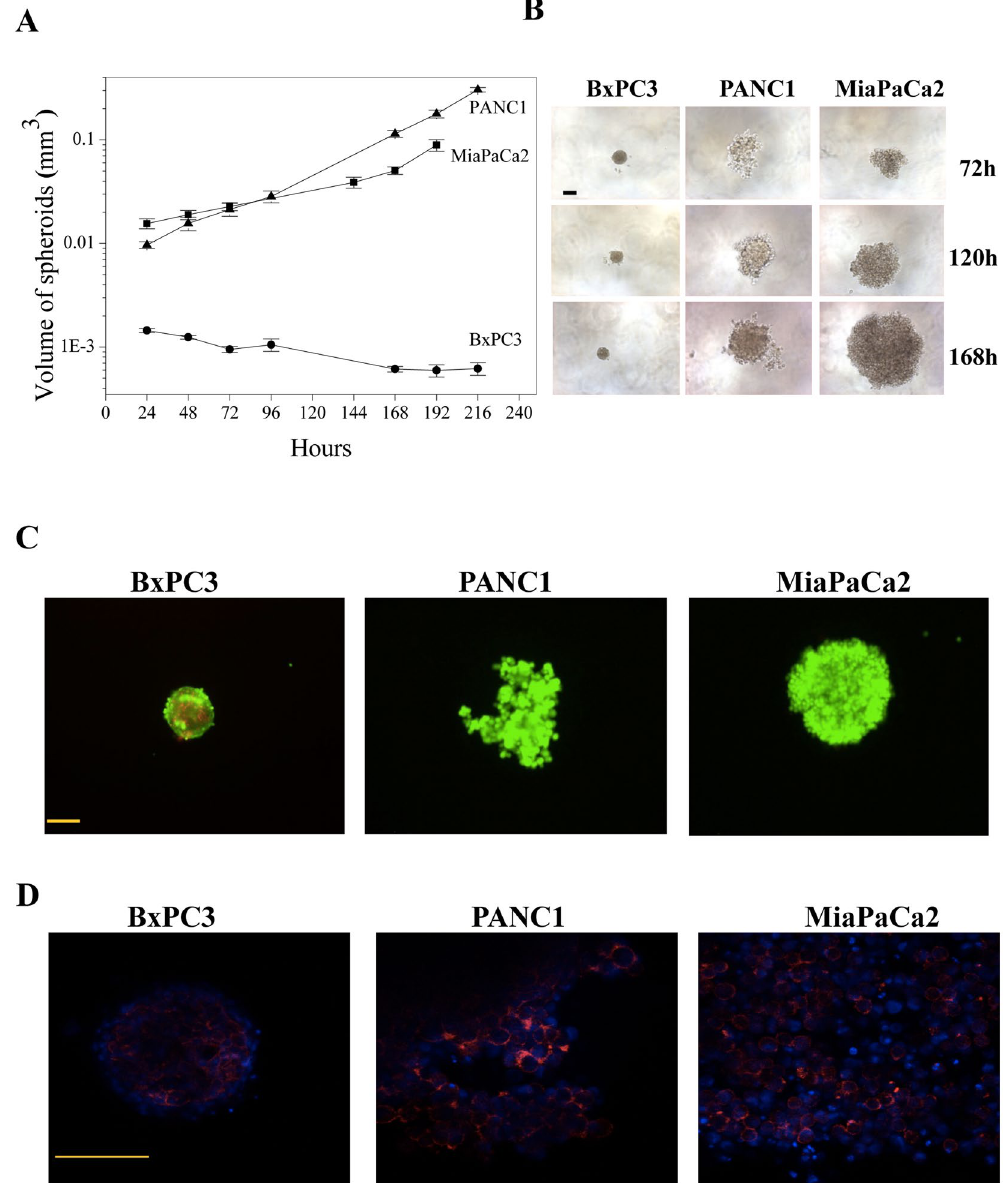
Figure 2. In vitro cell growth characteristics of PDAC cells in 3D culture conditions. (A) Comparison of growth rate between the PDAC cell lines with respect to difference in spheroid volume per day (n = 3). Data are means ± SEM of three separate experiments each carried out in triplicate. At the 0.05 level, data relative to MiaPaCa2 and PANC1 are not significantly different, whereas data relative to MiaPaCa2 are significantly different from those relative to BxPC3 (p = 0.003), and data relative to PANC1 are significantly different from those relative to BxPC3 (p = 0.002). (B) Microscopic images of PDAC at 72 h (top layer), 120 h (middle layer) and 168 h (bottom layer). (C) Live and dead cells were stained after 72H of culturing by Calcein (green) and PI (red) respectively. (D) Cytoskeleton organisation was studied by actin staining in all the three cell lines found to be on the periphery of cells. Scale bars represent 100 µ